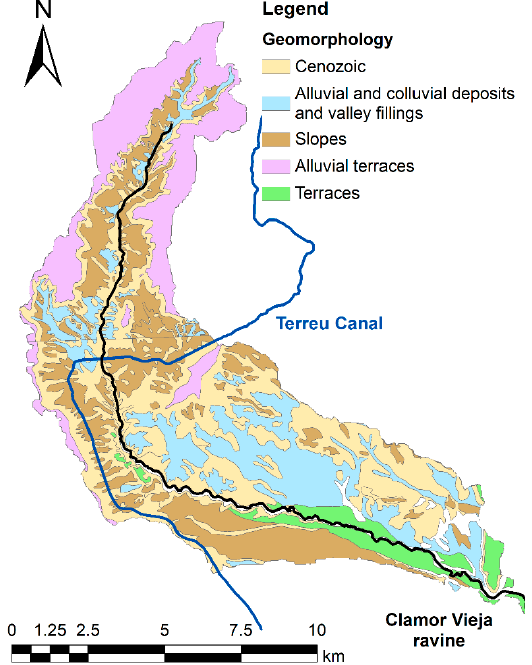
Figure 2. Geomorphology of Clamor Vieja basin.